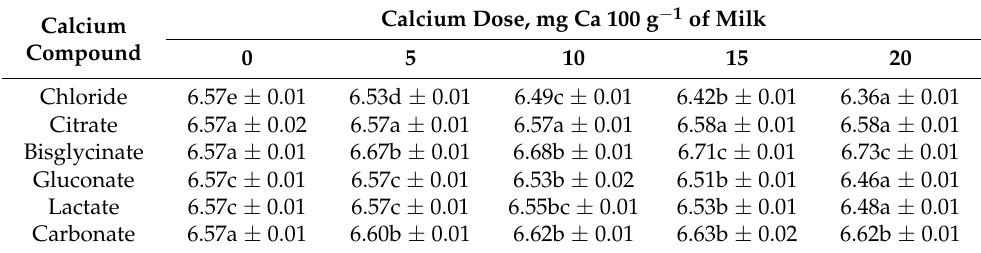
Calcium Dose, mg Ca 100 g − 1 of